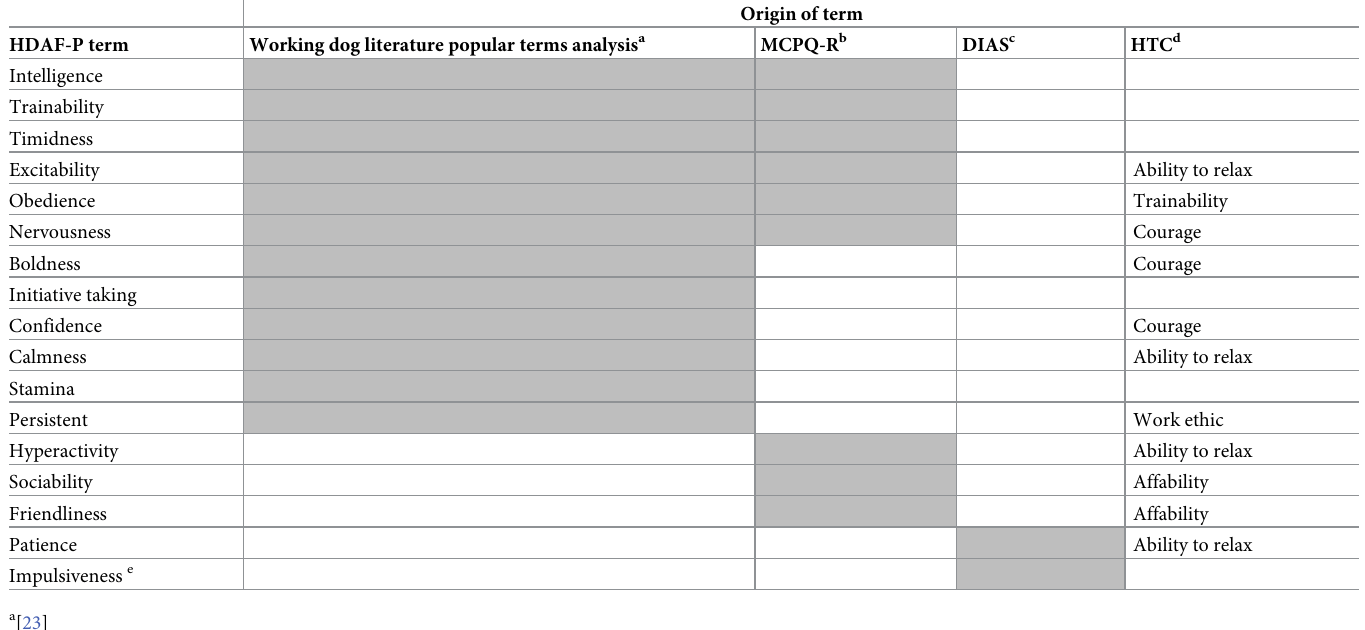
Table 1. The origin of 17 terms included in Herding Dog Assessment Form–personality (HDAF-P). A shaded cell indicates the origin of the HDAF-P term. Traits included in the HTC are listed next to related HDAF-P terms. Note that impulsivity is defined in dogs with sudden, strong urges to act; acting without forethought; acting without considering effects of